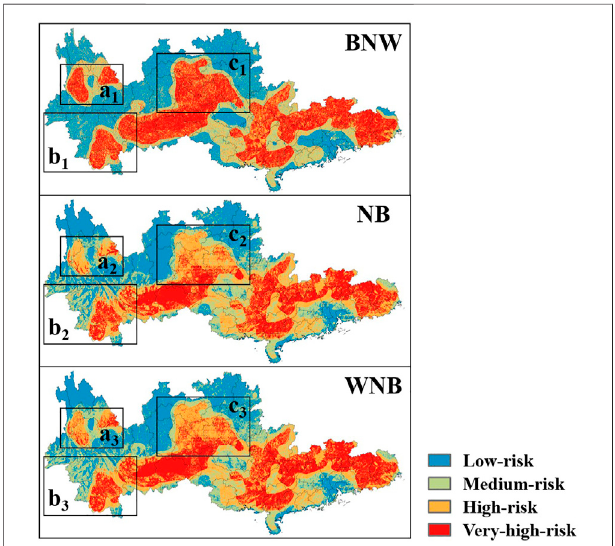
FIGURE 11 | The distributions of wild fi re risk levels based on BNW, NB, and